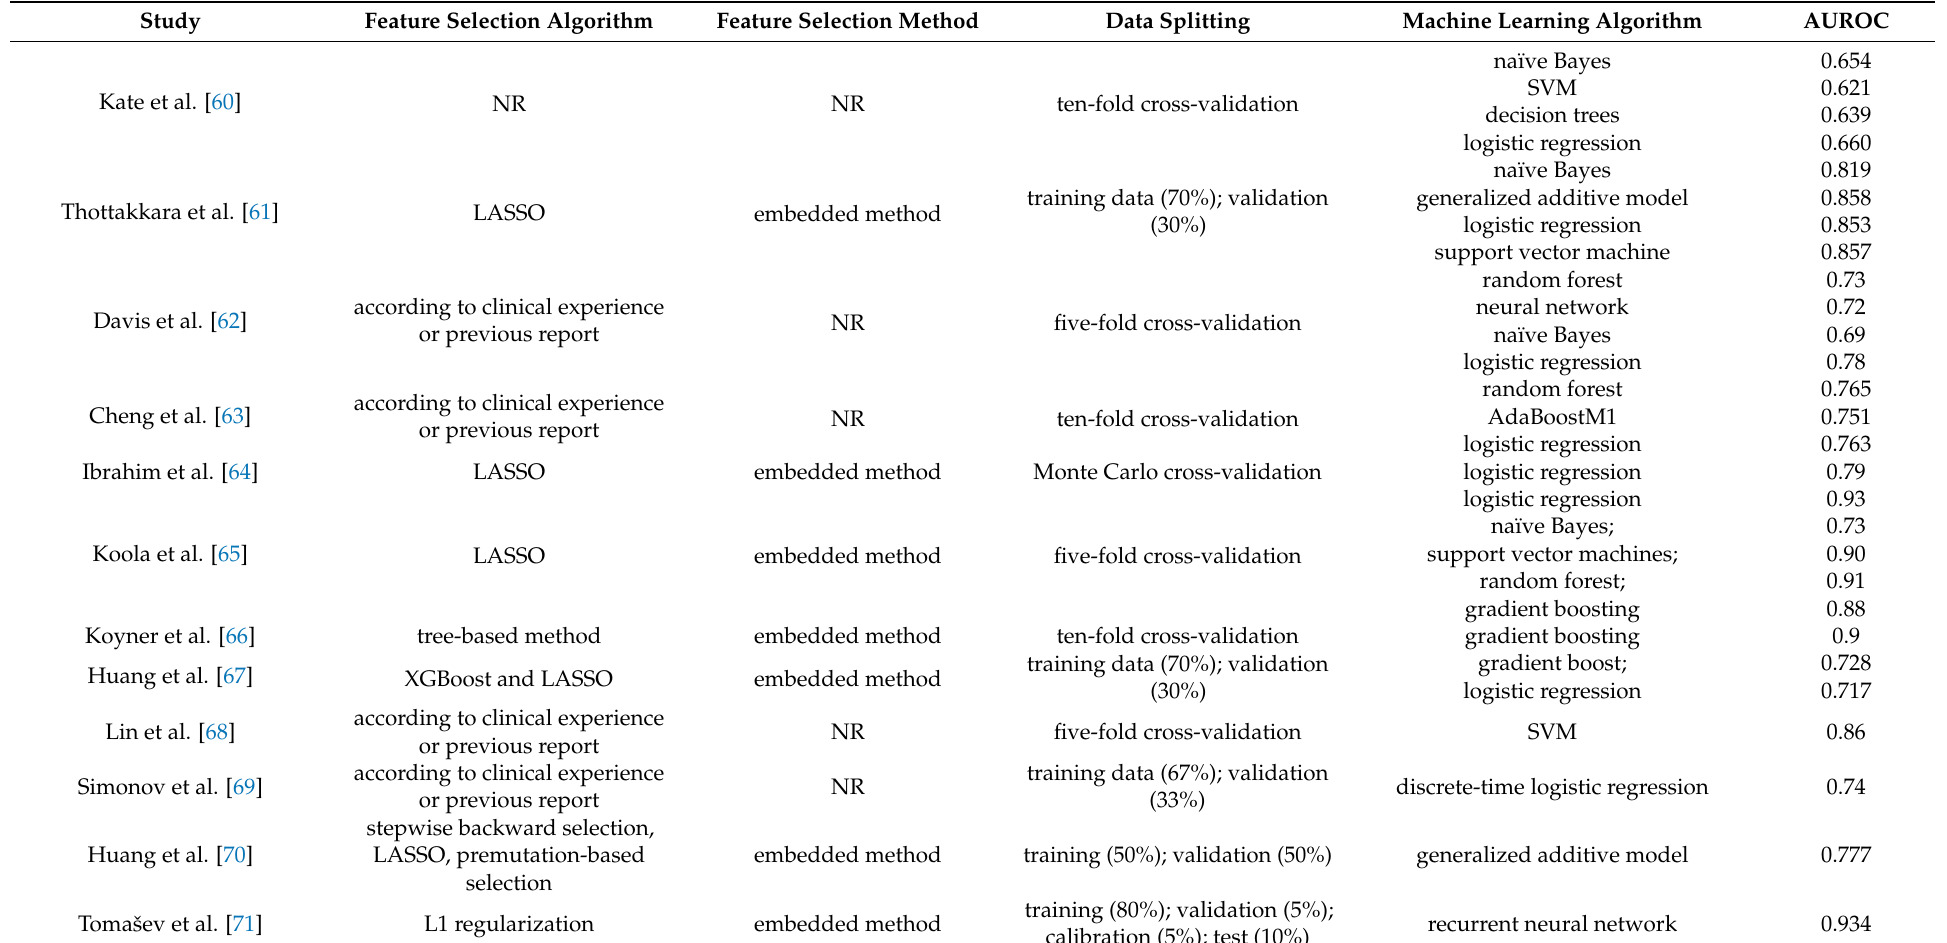
Table 2. Summary of data processing and performance of machine-learning algorithm in enrolled